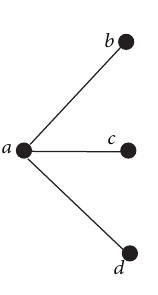
Figure 3: A local skeleton recovered from the marginal distribution of {𝑎,𝑏,𝑐,𝑑}